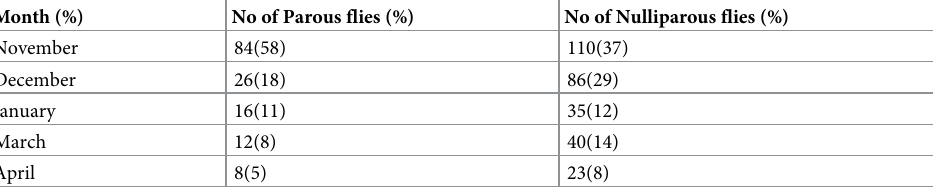
Table 2. Monthly variation in parous and nulliparous flies during the study